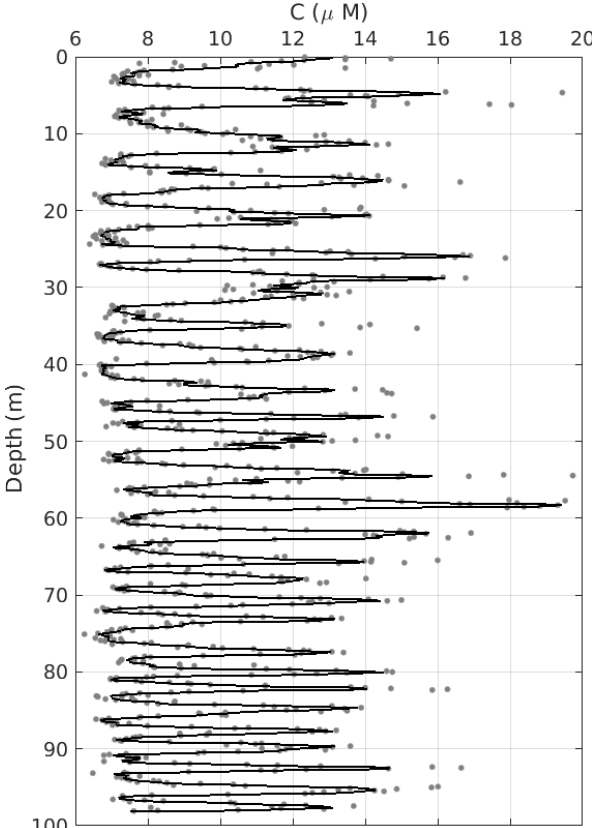
Figure 2. The grey dots are the raw data C (z) and the solid line is their smoothed version C (z) , both expressed in micromolar (µM) concentration. For the sake of visualisation, we have omitted just two data points with concentrations of C (z) > 20µM at depths ap- proximately equal to